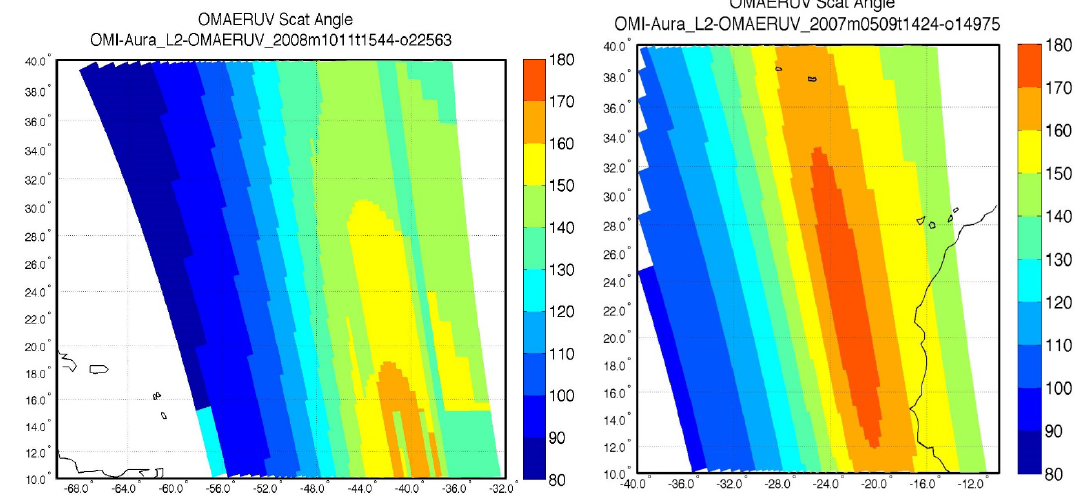
Figure A2. Scattering angles for the two dust case studies: 11 October 2008 (left) and 9 May 2007